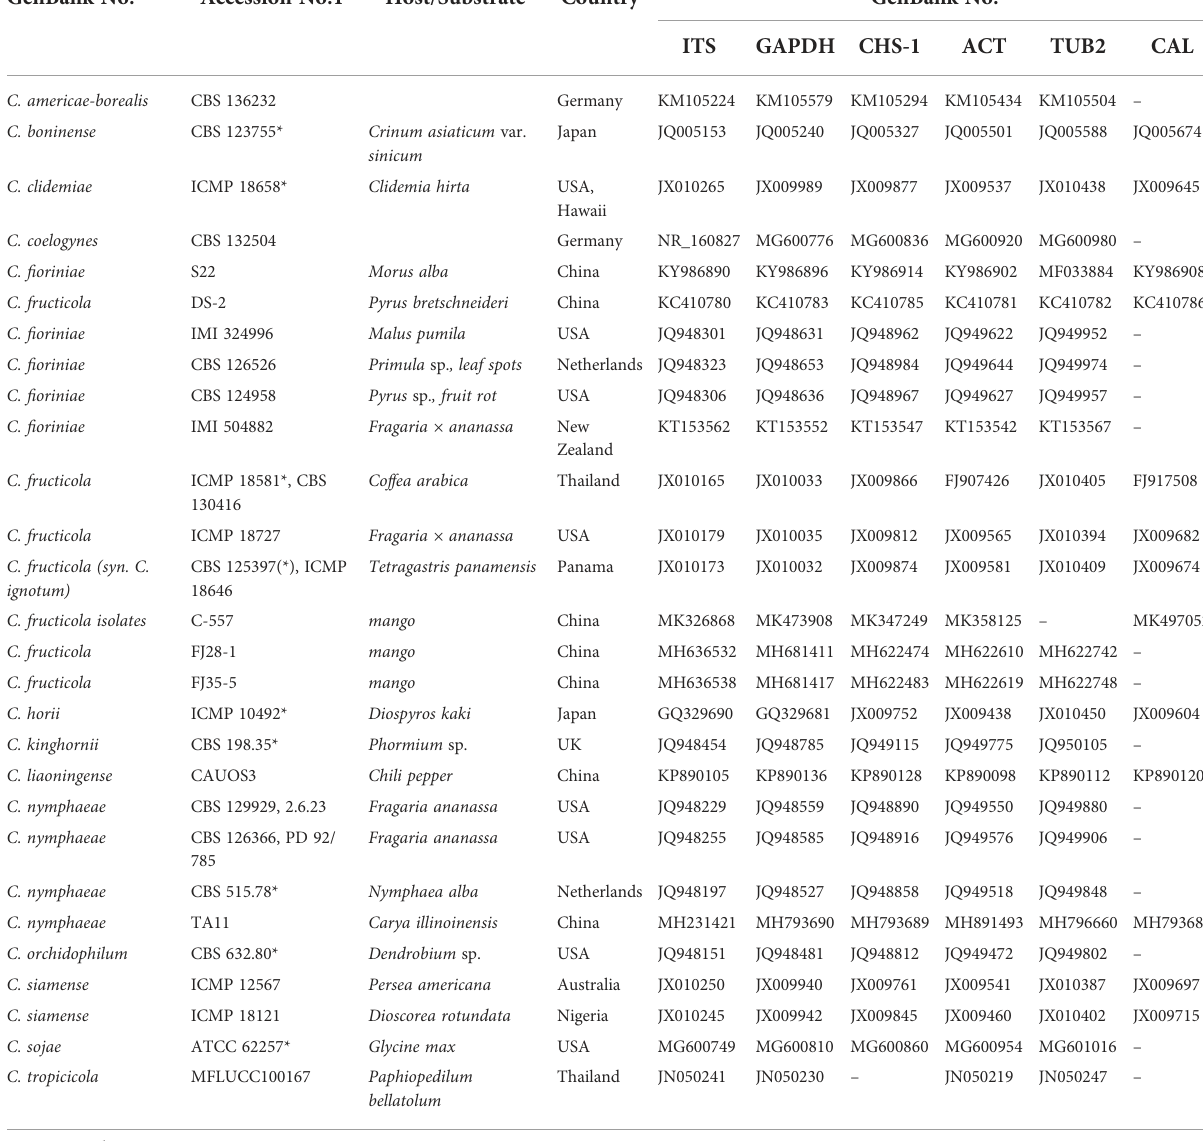
TABLE 3 Sequences of Colletotrichum spp. isolates used in the phylogenetic analysis. GenBank